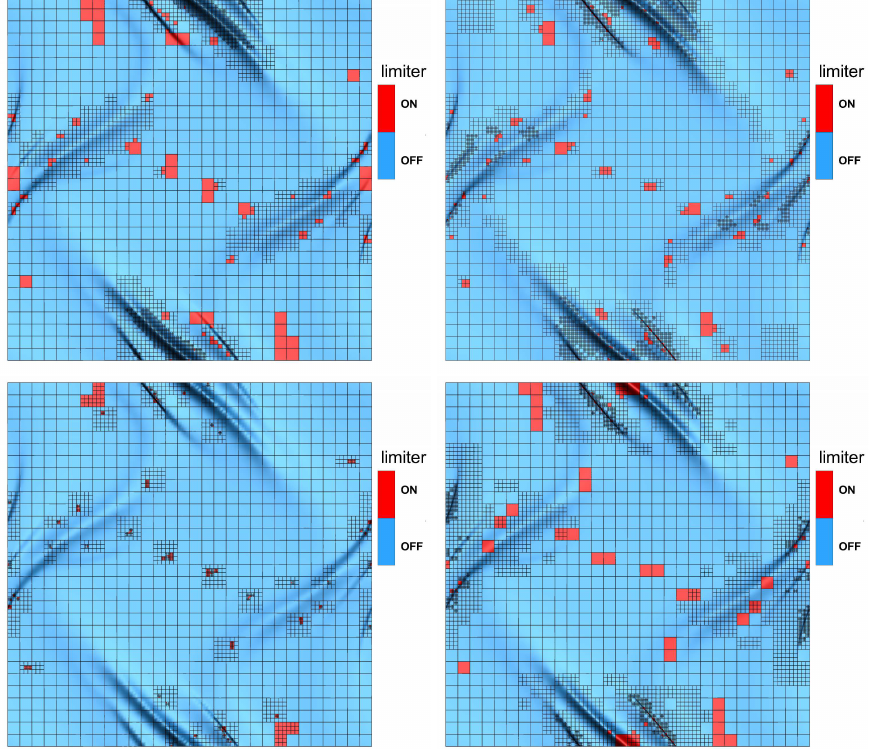
Figure 6. Results for the GRMHD Orszag-Tang vortex problem in flat space–time (SRMHD) at t = 2 obtained with ADER-DG- P 5 schemes, supplemented with a posteriori subcell finite volume limiter and using different refinement estimator functions χ . (i) first order-derivative estimator χ 1 ( top left ); (ii) second-order derivative estimator χ 2 ( top right ); (iii) a new limiter-based estimator χ 3 (row two, left ) and (iv) a new multi-resolution estimator χ 4 based on the difference between the discrete solution on two adjacent refinement levels (row two, right